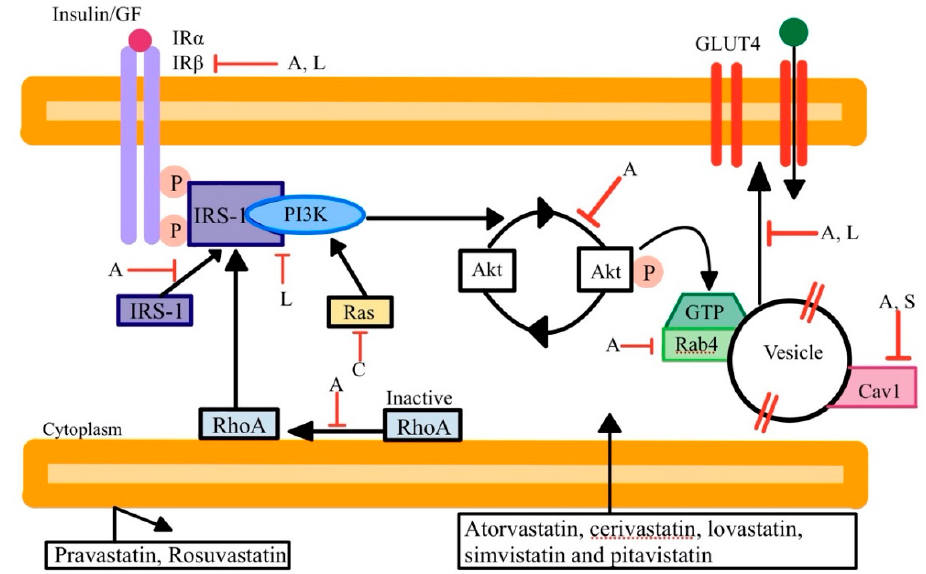
Figure 4. Proposed mechanisms of statin-induced type 2 diabetes mellitus. Hydrophobic statins (pravastatin, rosuvastatin) require active transport to enter the cell ( left of figure). Lipophilic statins (atorvastatin, cerivastatin, lovastatin, simvastatin, pitavistatin) can freely diffuse across the cell membrane ( right of figure). The first letter of each statin is listed where it acts in the insulin secretion pathway. Akt, protein kinase B; A, Atorvastatin; Cav1, caveolin 1; C, Cerivastatin; GF, growth factor; GLUT 4, glucose transporter type 4; IR, insulin receptor; IRS-1, insulin receptor substrate 1; L, Lovastatin; P, phosphate; PI3K, phosphoinositide 3 kinase; Rab4, ras-associated binding protein 4; Ras, rat sarcoma; S, Simvastatin.